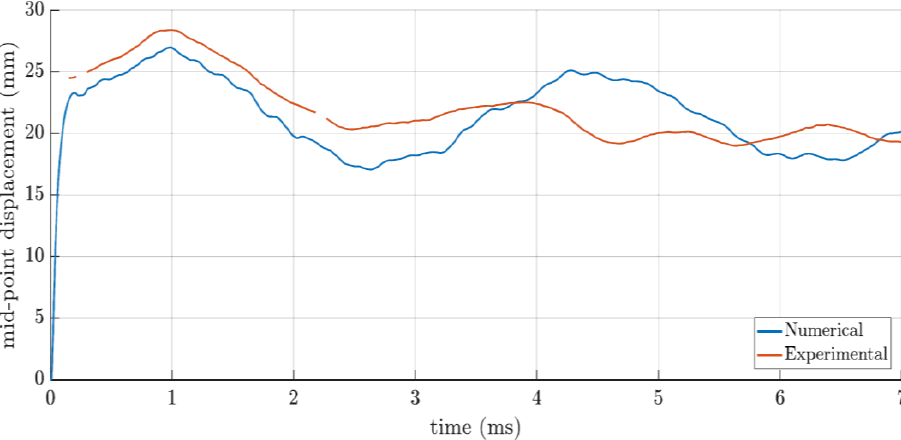
Figure 19. Graph of transient midpoint displacement versus time for a 120° V-structure with a 32 mm tip radius subjected to a 15 g detonation, comparing experimental and simulated data.